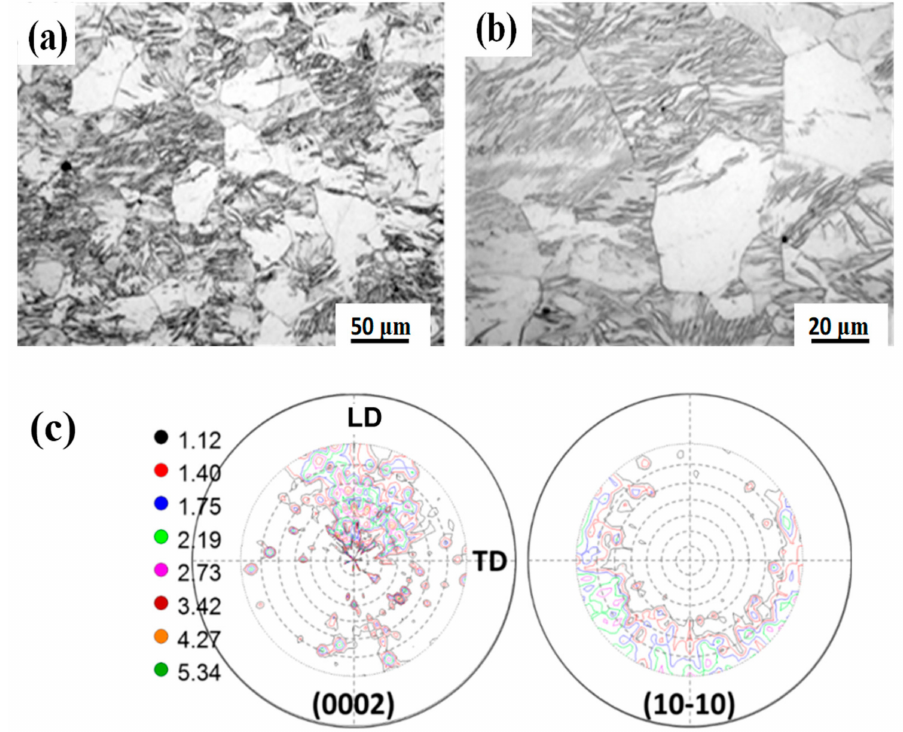
Figure 1. Showing ( a , b ) the microstructure of the multiple-axial forged (MAFed) Mg with di ff erent magnifications, and ( c ) the (0002) and (1010) pole figures of the MAFed samples, in which LD represents longitudinal direction; TD represents transverse